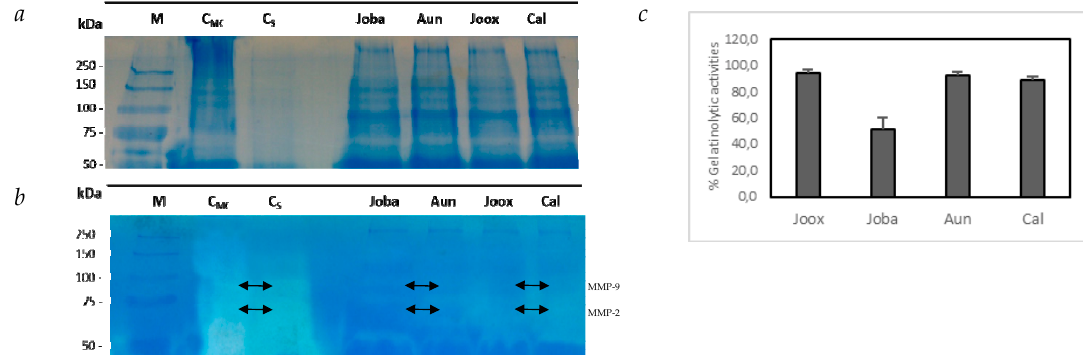
Figure 3. Gelatinolytic activity for all total protein extracts carried was out on SDS-PAGE NR gel. ( a ) Control gel on polyacrylamide of 12.5% ( m / v ), staining by CBB G250, representative of samples from the extracellular medium after incubation with Juniperus oxycedrus subsp. badia (Joba), Arbutus unedo (Aun), Juniperus oxycedrus subsp. oxycedrus (Joox) and Corema album (Cal) extracts: 5 µL from the molecular weight marker (M) and 20 µL extracellular medium were applied of each sample as for medium controls, complete medium control (CMC) and control with saline (CS). ( b ) Zymographic test carried out on 12.5% ( m / v ) polyacrylamide gel containing 1% ( m / v ) gelatin and staining by CBB G250, representative of samples from the extracellular medium, collected at the end of the inhibition test of cell migration. 5 µL of molecular weight marker (M) and 20 µL of all samples were also applied. ( c ) Proteolytic activity of gelatinases present in the HT29 extracellular media after a 48 h-exposure to 100 µg·mL − 1 of buffer-soluble fractions from all species, as quantified by the DQ fluorogenic method. Results are expressed as relative fluorescence as a % of controls and represent an average of at least three replicate experiments ± SD ( c ). The arrows highlighted the presence of metalloproteinases MMP-9 and MMP-2.